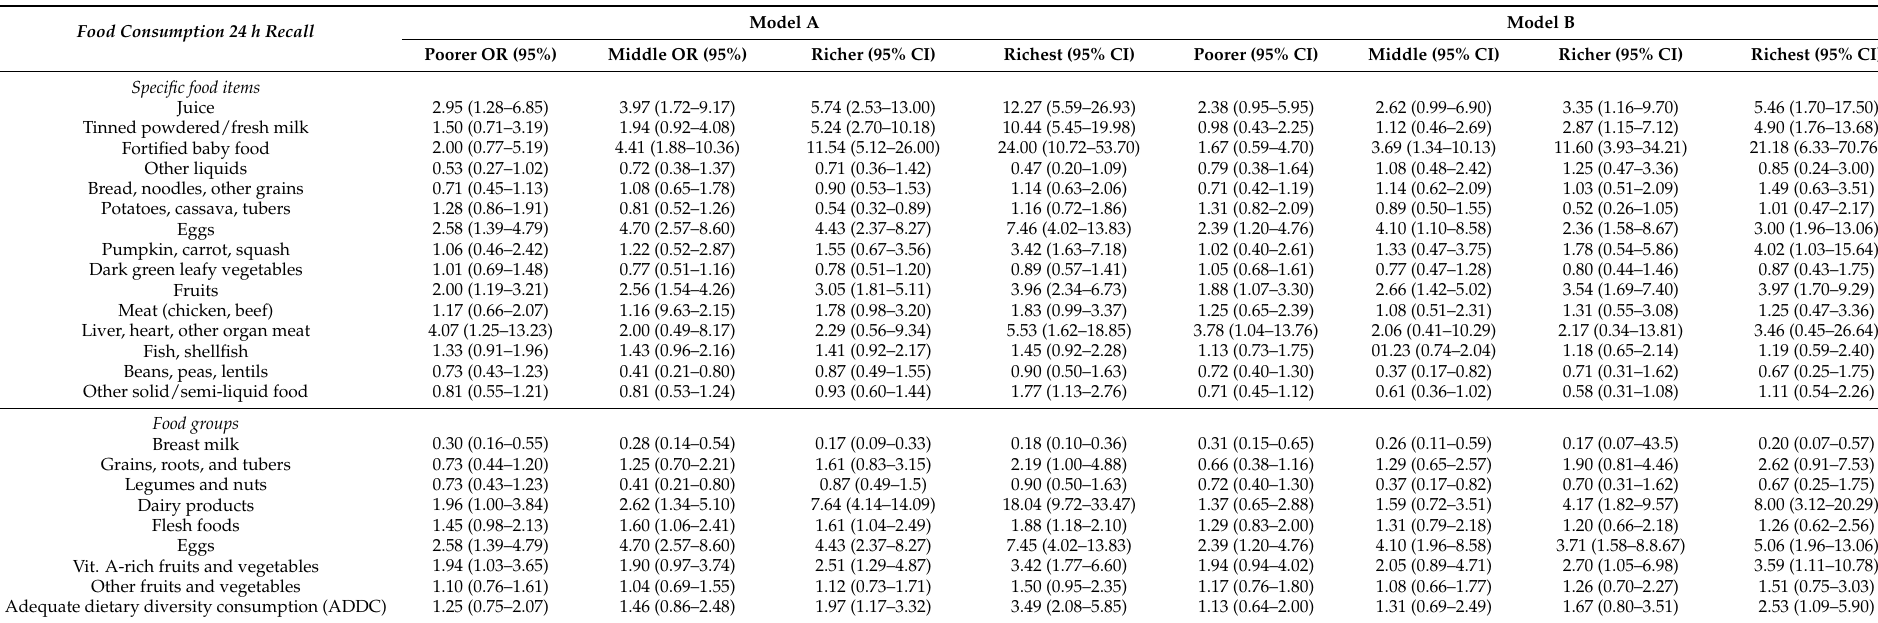
Table 6. The association between household wealth and consumption of food items, food groups, and adequate dietary diversity of children aged 6–23 months, adjusted odds ratios (ORs) with confidence intervals (Cis),